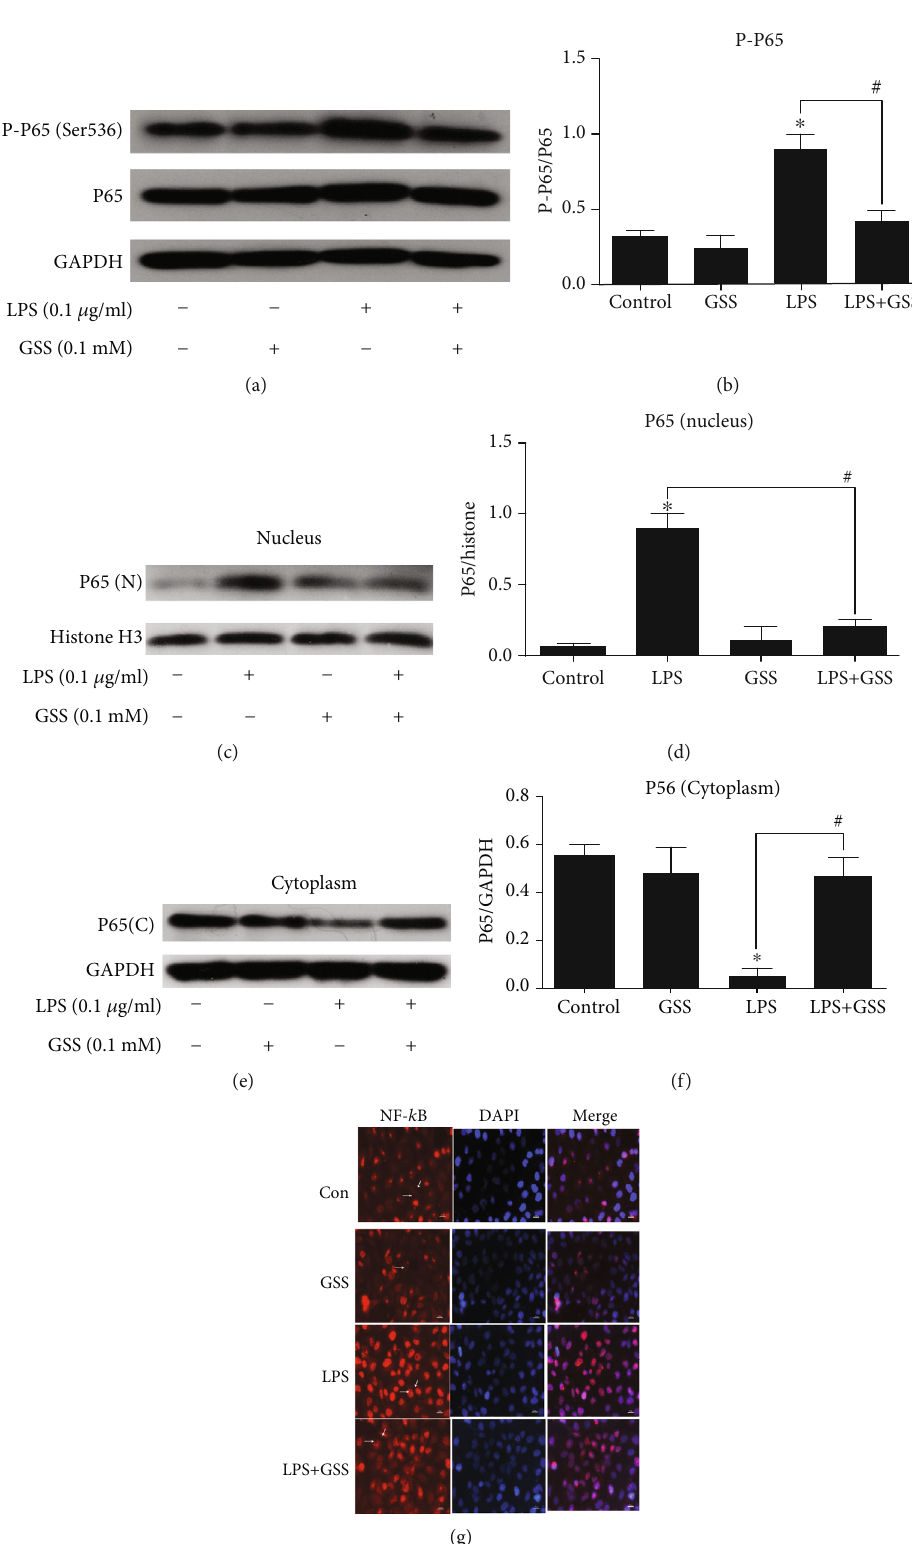
Figure 5: E ff ects of GSS on the LPS-induced activation of NF- κ B in ECs. (a, b) GSS had a signi fi cant inhibitory e ff ect on LPS-induced increase of P-P65 expression compared to the LPS-stimulated group. (c, d) The expression of P65 in the nucleus of ECs was measured by Western blot analysis. (e, f) P65 expression in the cytoplasm of ECs was measured by WB assay. (g) The nuclear translocation of NF- κ B was analyzed using the confocal microscope ( × 200 magni fi cation), which revealed that GSS e ff ectively blocked LPS-induced P65 translocation into the nucleus of ECs. ∗ P < 0 : 05 versus negative control. # P < 0 : 05 versus the corresponding LPS treatment